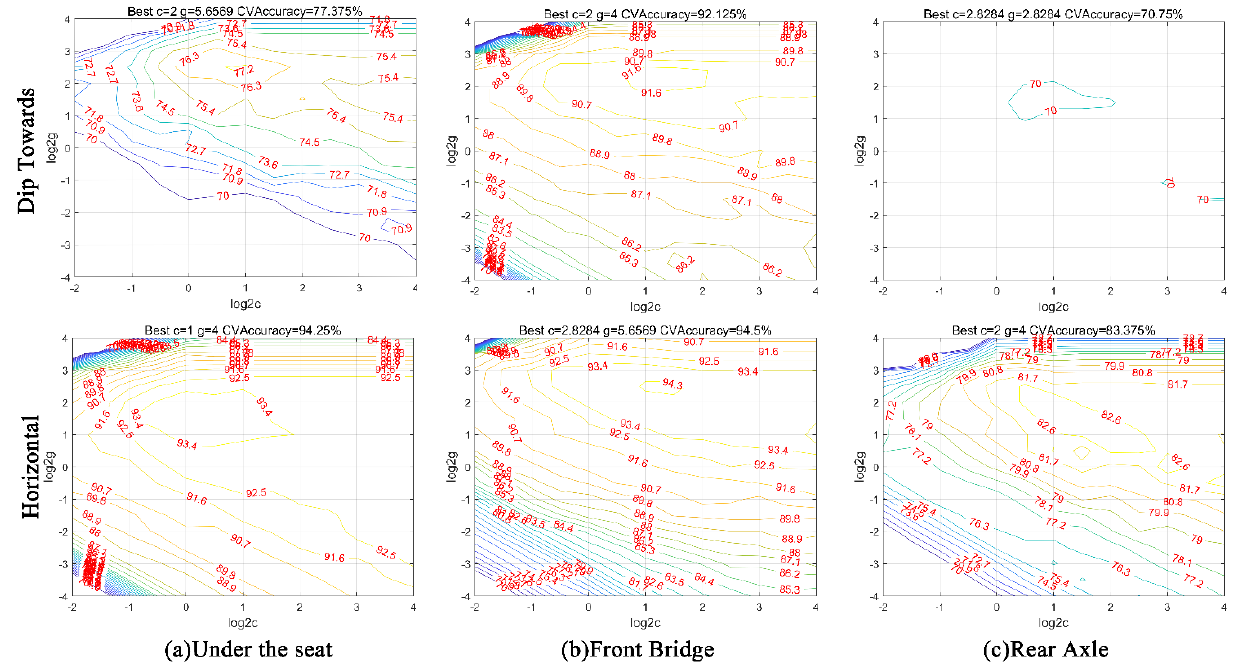
Figure 10. SVM cross-validation parameter selection results.